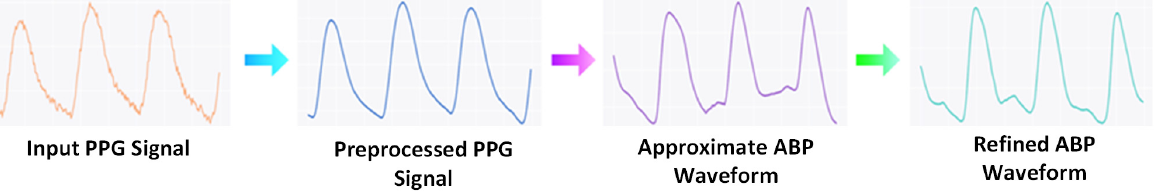
Figure 1. Algorithmic pipeline of PPG2ABP. PPG2ABP takes PPG segments of T (cid:2915) seconds long as